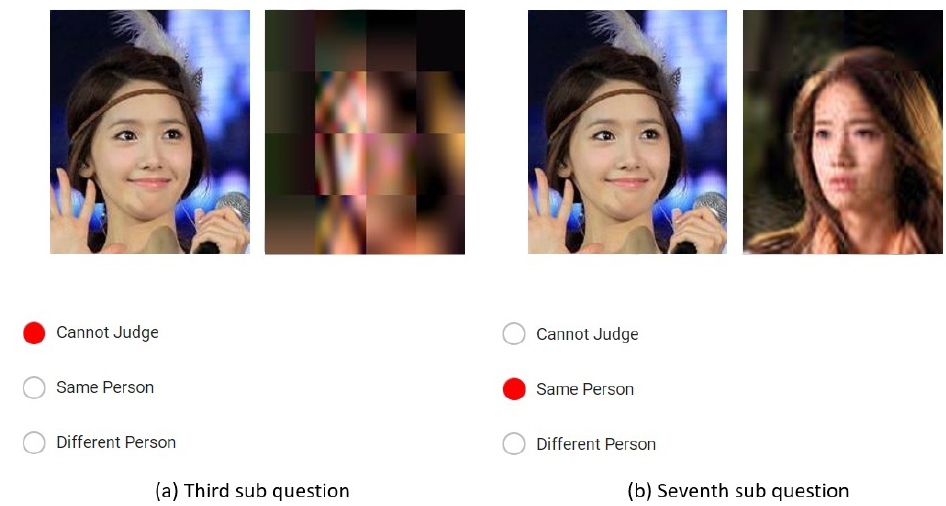
Figure 6. The composition of a user study. The image on the left of each sub-question is the original image. ( a ) The image on the right of the third sub-question is transformed by DCC ( r = 64 ) . ( b ) The image on the right of the seventh sub-question is transformed by DCC ( r = 1024 ) .